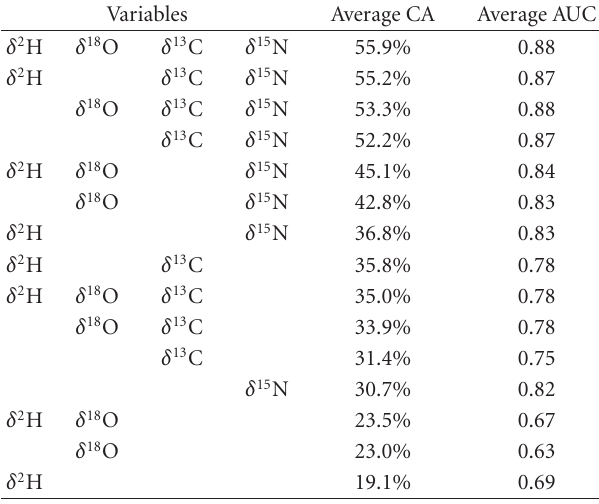
Table 2: The average CA and AUC for all possible combination of the variables in the LeIR data.